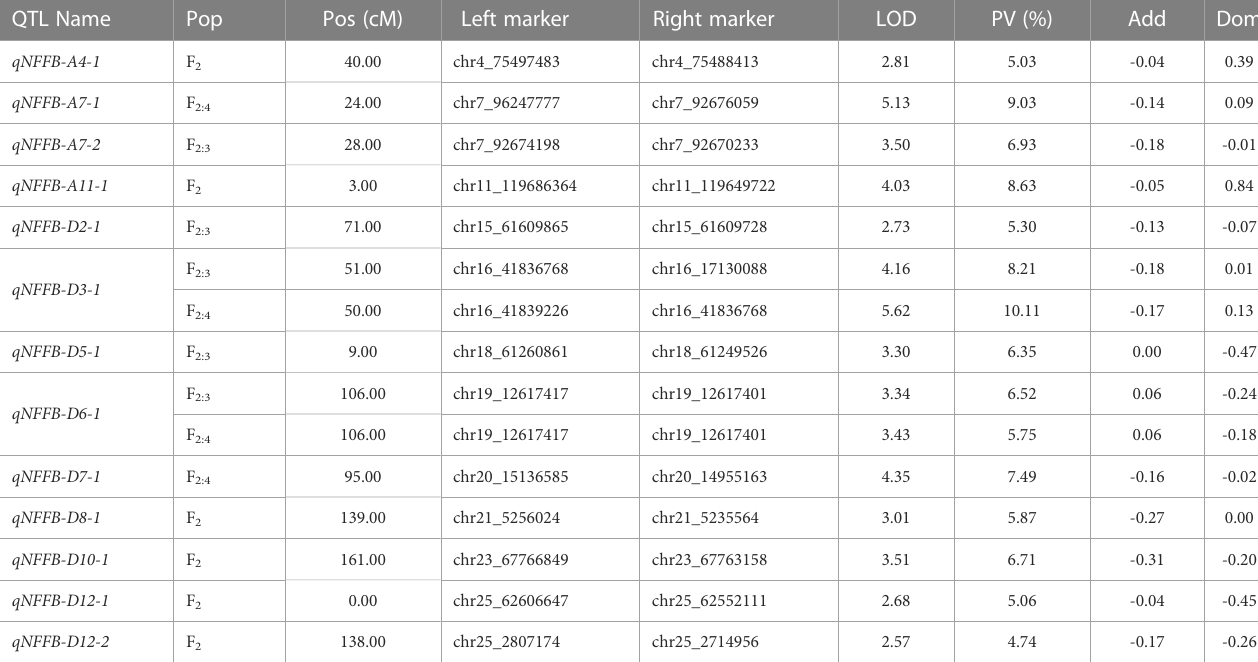
TABLE 5 Detailed information of the mapped